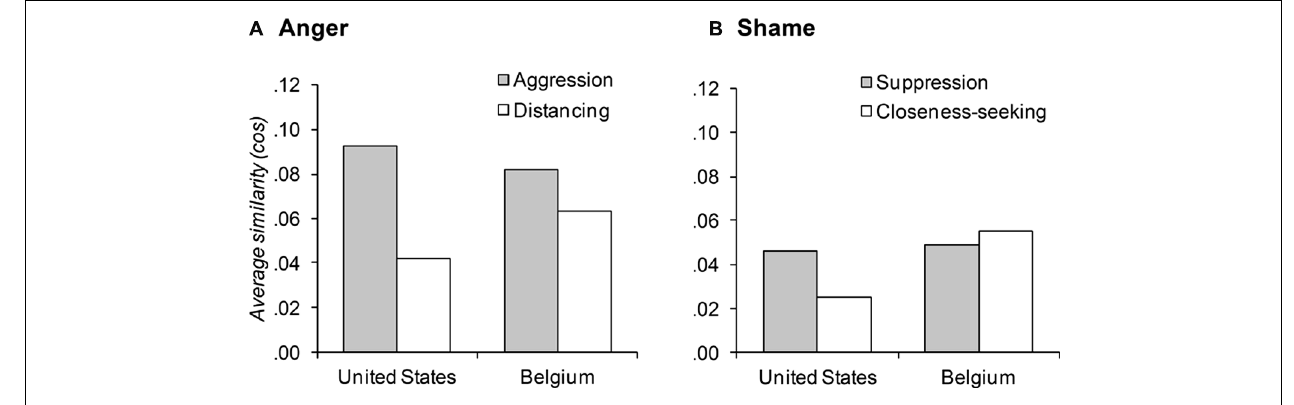
FIGURE 3 | Similarity between emotion words and words reflecting emotional responses in the United States and